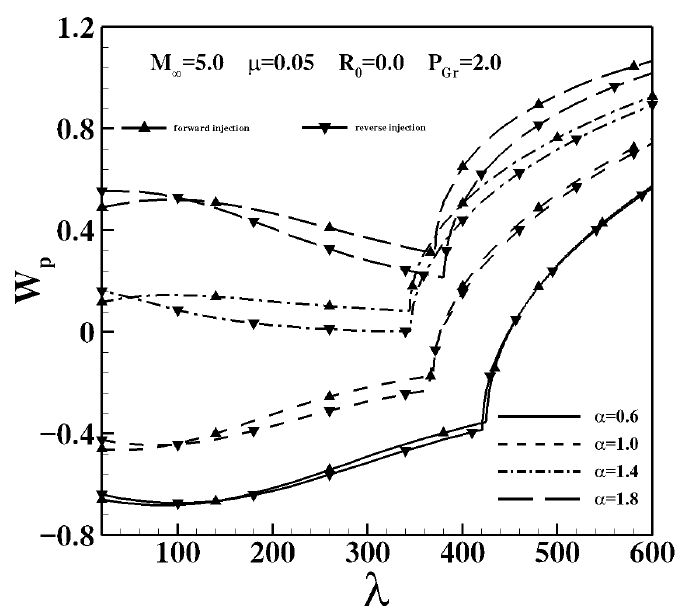
Figure 14. Peak of deformation versus dynamic pressure under different injection directions.